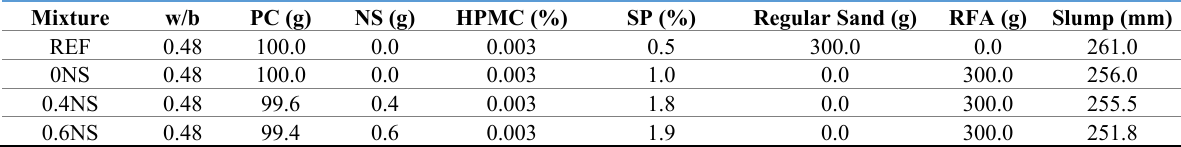
Table 3. Detailed composition of the mortar mixes per 100 g of